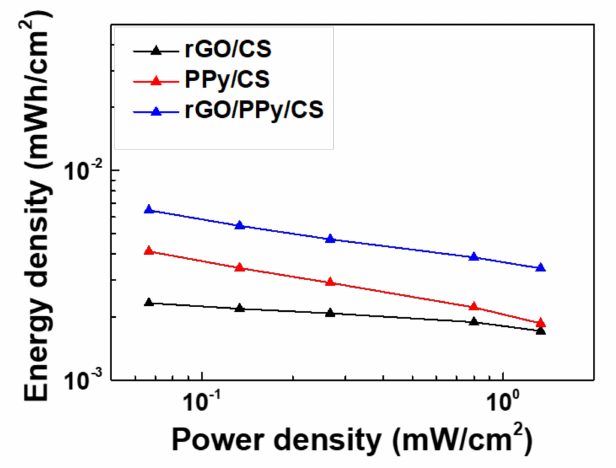
Figure 8. Ragone’s plots of SCs with rGO/CS, PPy/CS and rGO/PPy/CS nanocomposite.